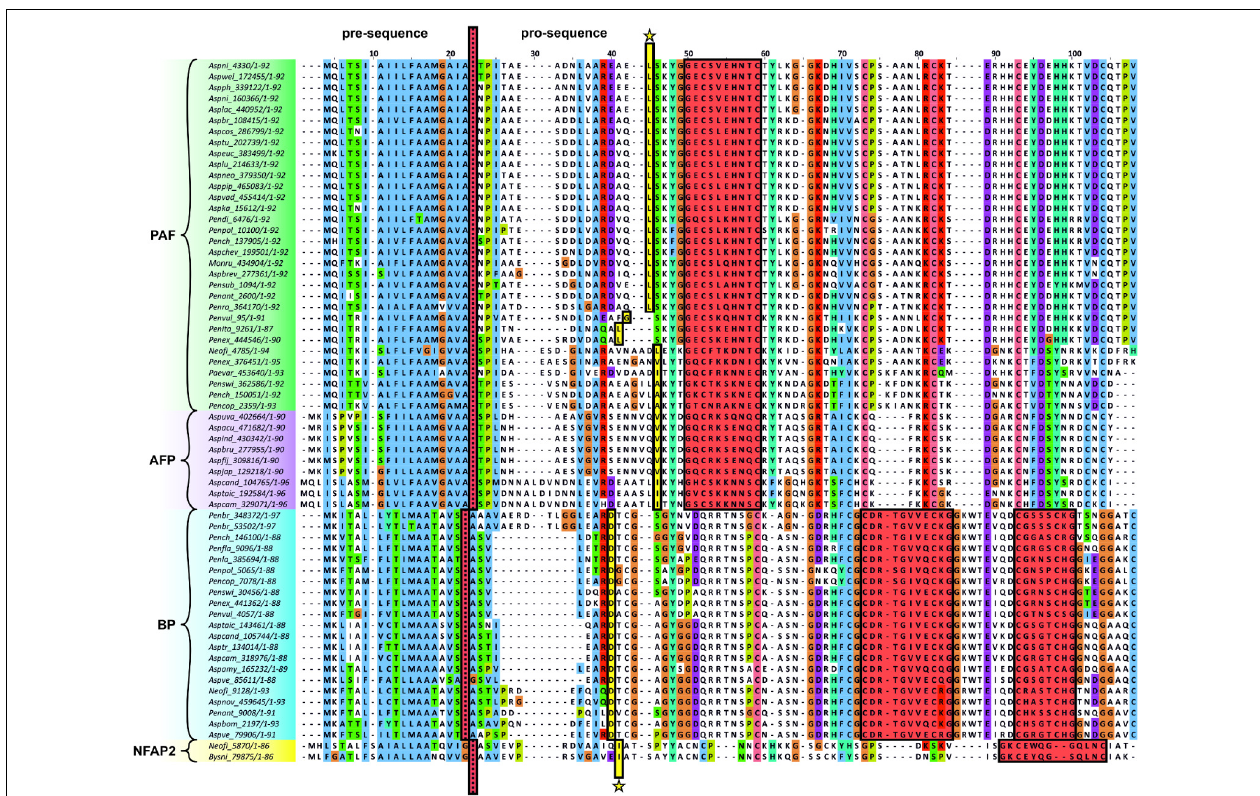
FIGURE 8 | Clustal W multiple alignment of the putative AMPs from Eurotiomycetes. Dotted red line indicates the cleavage site of the predicted signal sequence. First amino acid of the mature protein is marked by an asterisk. The γ -core motifs are framed and highlighted in red. Abbreviation of the species name and the accession number of the respective AMP (listed in Supplementary Table S6) are indicated. The Clustal X default color scheme was applied